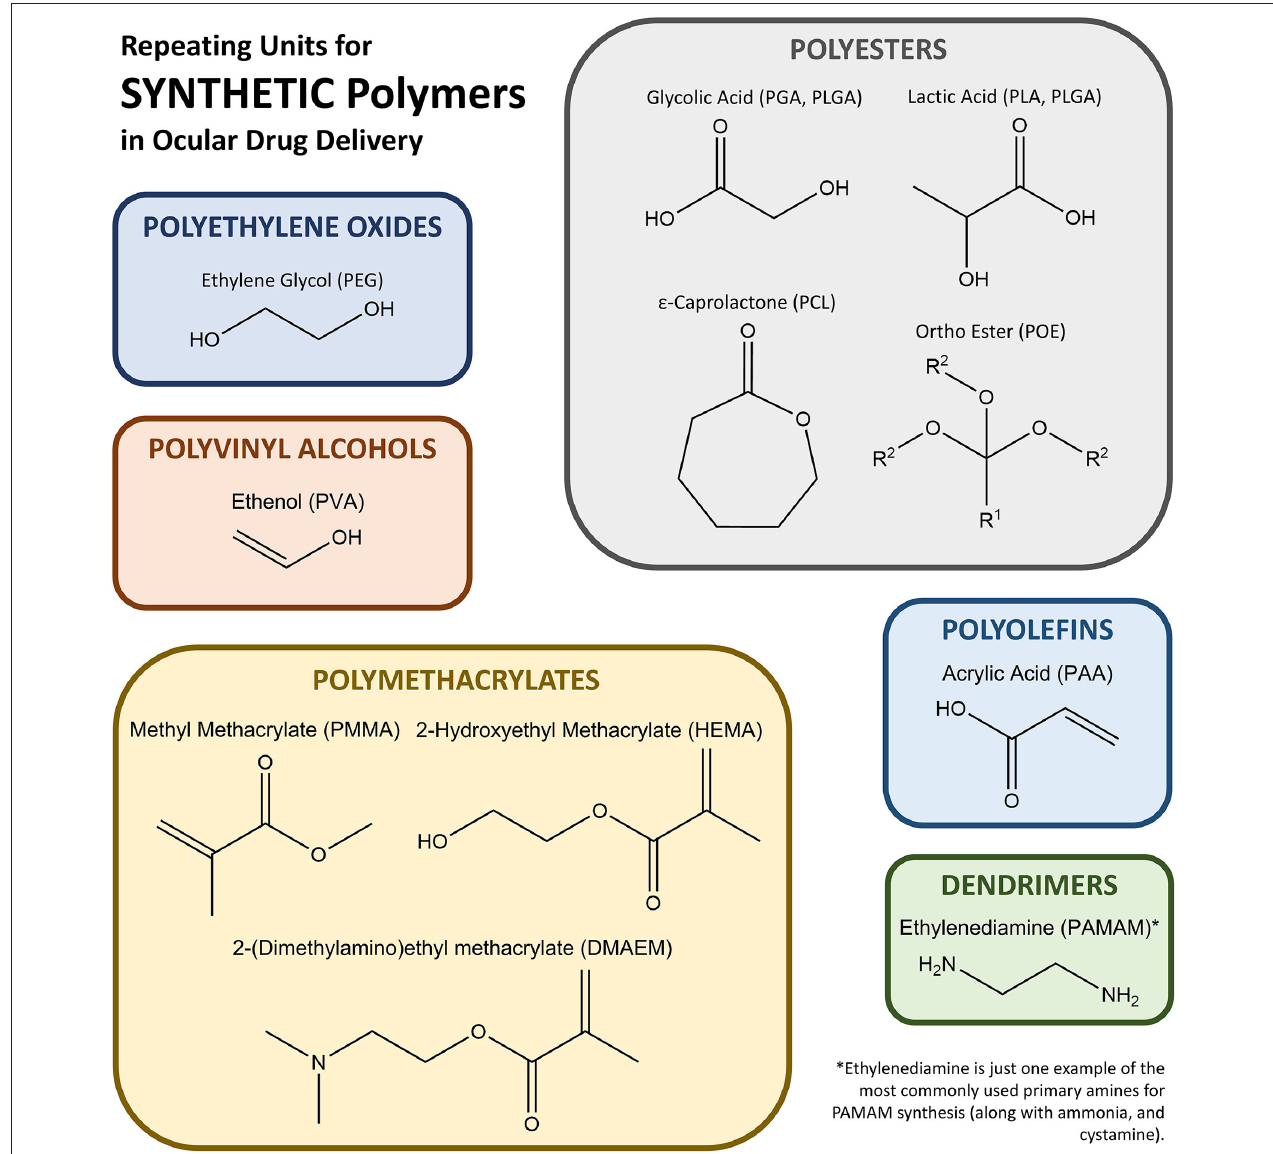
FIGURE 1 | Schematic of monomers that form the most common synthetic polymers used in ocular drug